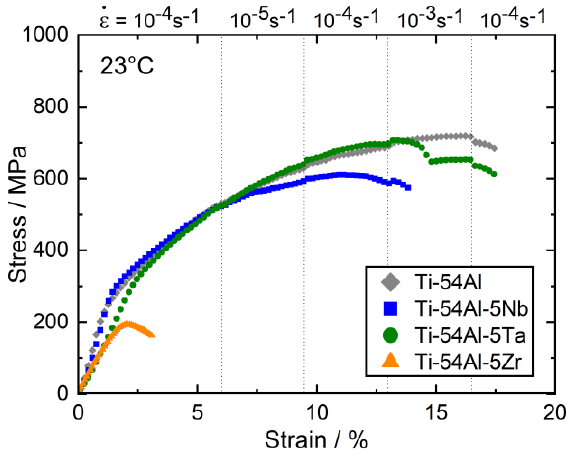
Figure 5. Compression stress-strain curves of strain rate jump tests at room temperature of the Ti-54Al-5X alloys and Ti-54Al.